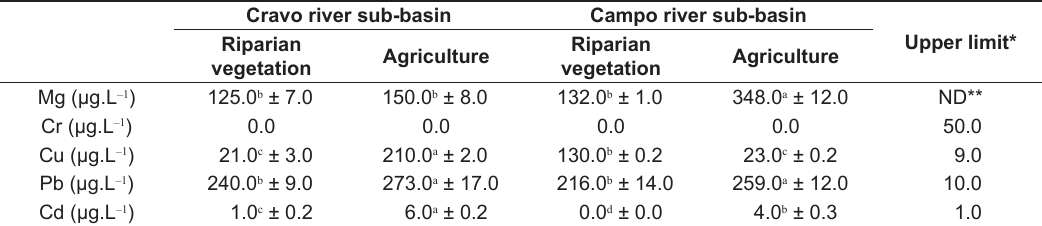
Upper limit*Riparian